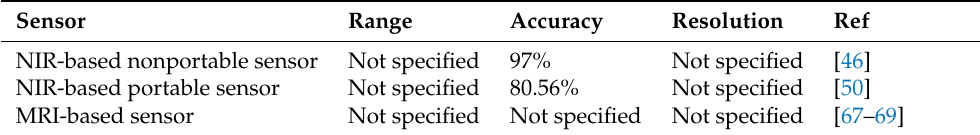
Table 6. Specifications of nondestructive Brix sensors reported in the literature.